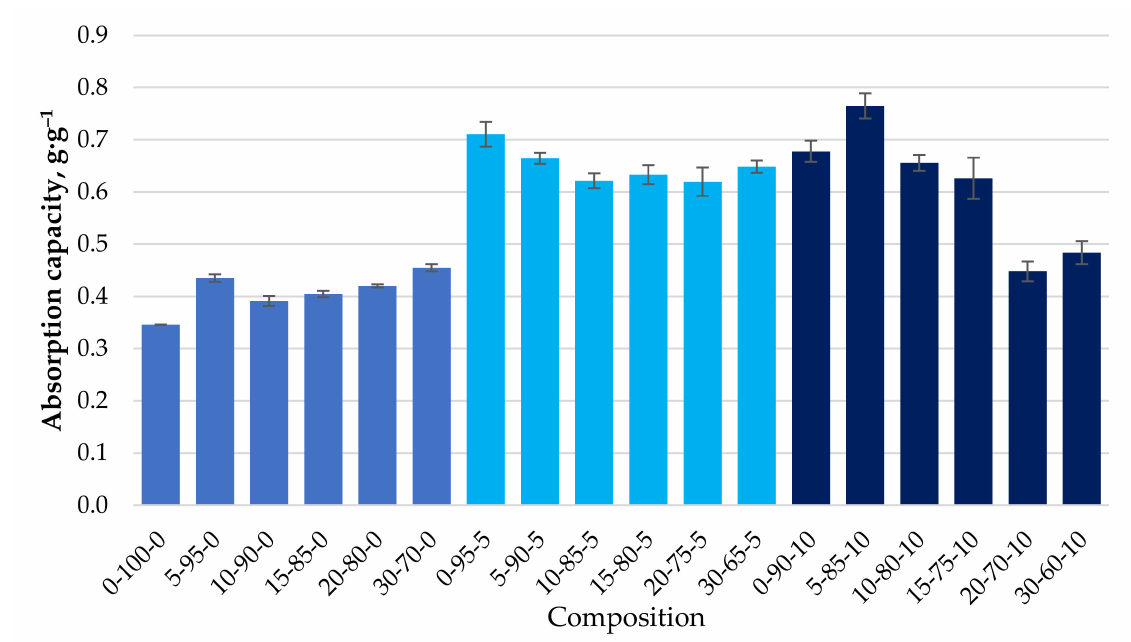
Figure 11. Absorption capacity (g · g − 1 ) of MO depending on the composition of the